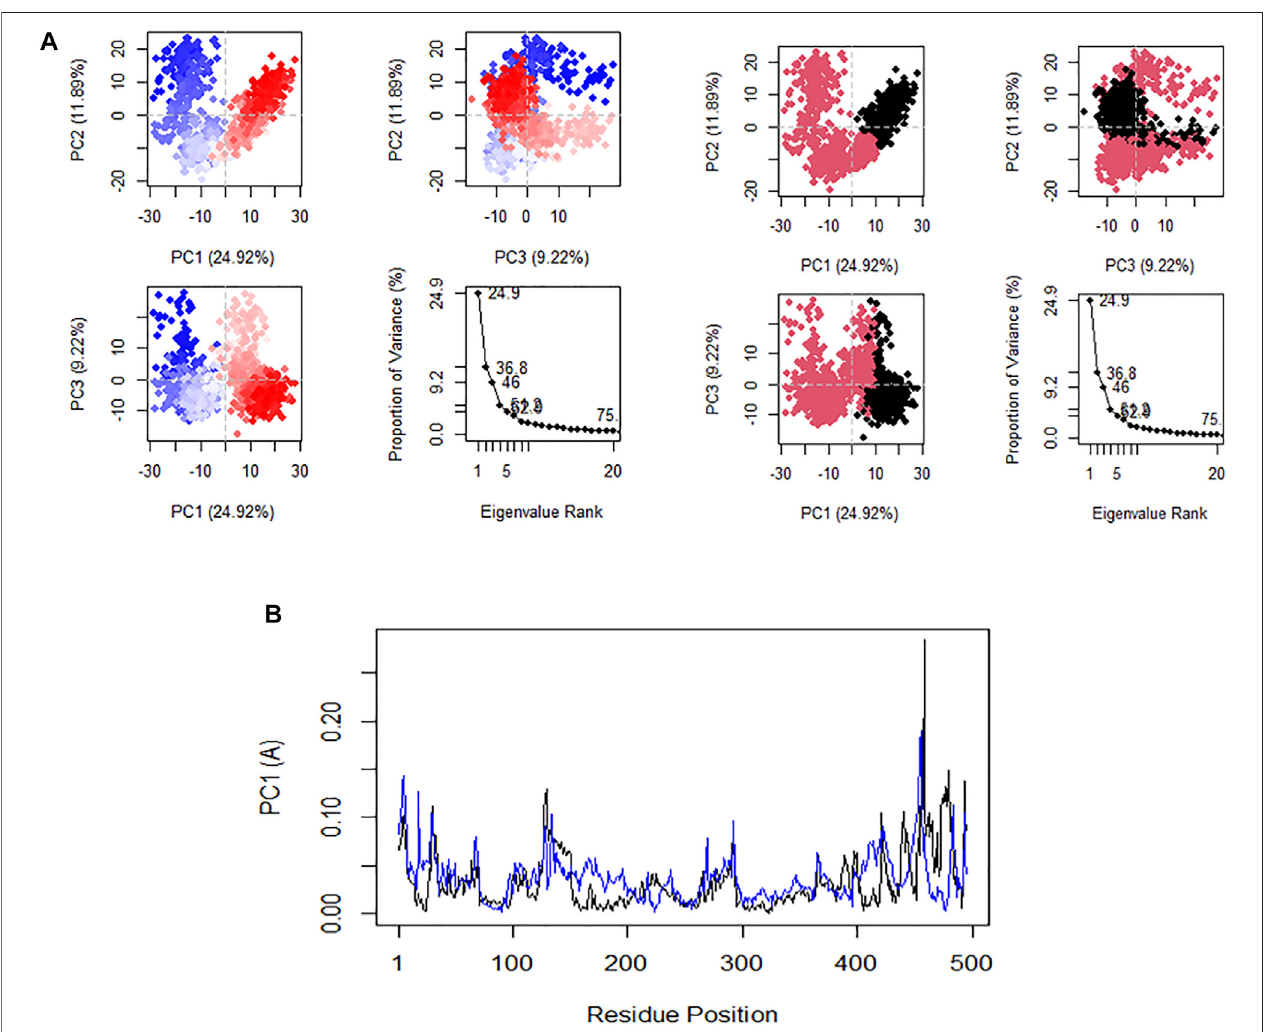
FIGURE 7 | (A) Plot of PCA results in an eigenvalue rank: PC2 vs. PC1, PC2 vs. PC3, PC3 vs. PC1, showing color in order of time and the cumulative variability in each data point. (B) Residues fl uctuated on the PC1 (black) and PC2 (blue).